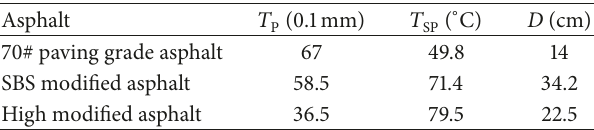
Table 1: Technical parameters of asphalt.